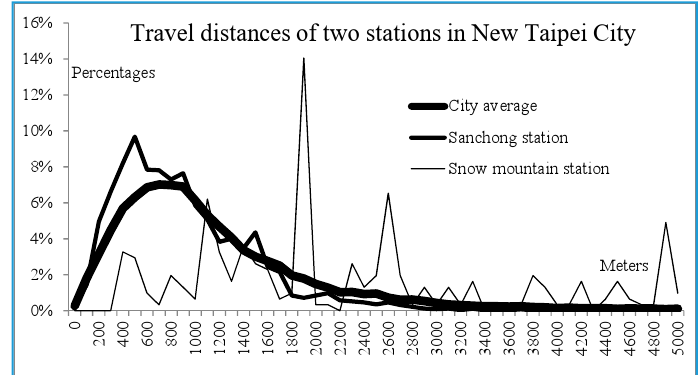
Figure 2. Travel distance distributions for Sanchong and Snow Mountain stations. (x: meters, y: frequency).